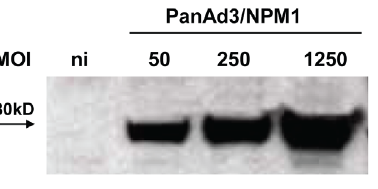
Figure 2. Detection of influenza antigens expressed by vectors in cultured cells. Western blot analysis of HeLa extracts prepared as described after 48 hours infection with PanAd3NPM1 at 50, 250, 1250 MOI (ni=not infected). The blotted proteins were revealed with a mouse hyperimmune serum raised against the NPM1 antigen. The 80 kD major band is consistent with the fusion NPM1